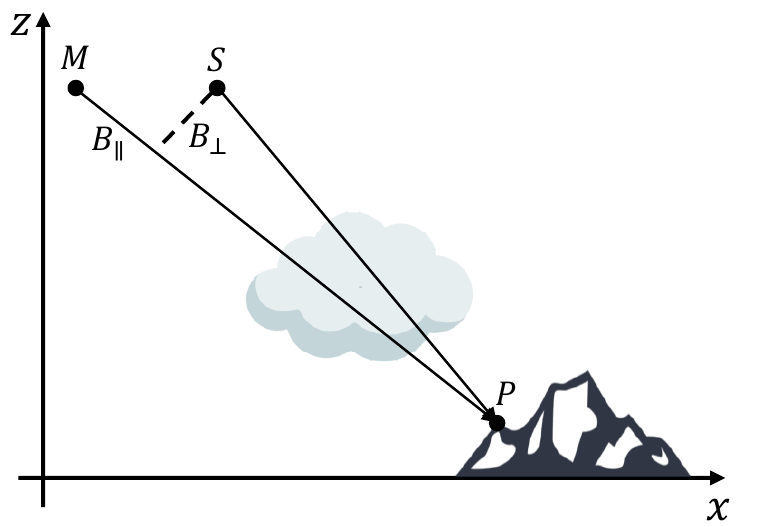
Figure 1. Synthetic Aperture Radar (SAR) acquisition geometry in the zero Doppler plane. The position of the satellite in the master acquisition is defined as M, the slave acquisition is defined as S. The point on ground is defined with the letter P.